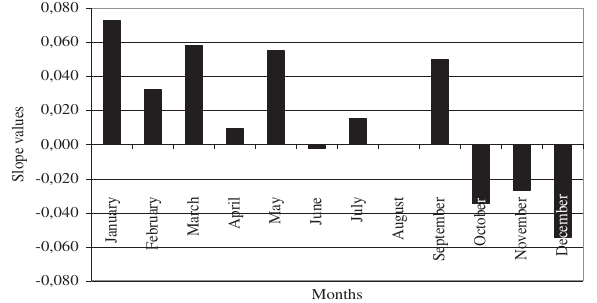
Figure 6 – The mean monthly slopes of the linear trendfunction of absolute temperature minima measured on 16 stations (1951–2010)